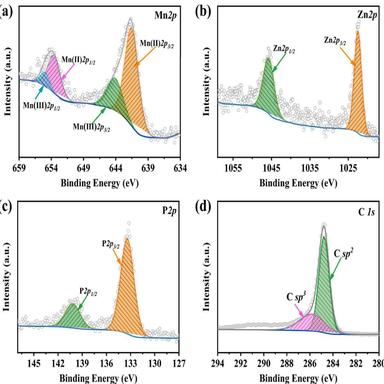
X-ray photoelectron spectroscopy (XPS) spectra of (a) Mn 2p, (b) Zn 2p, (c) P 2p, and (d) C 1s.